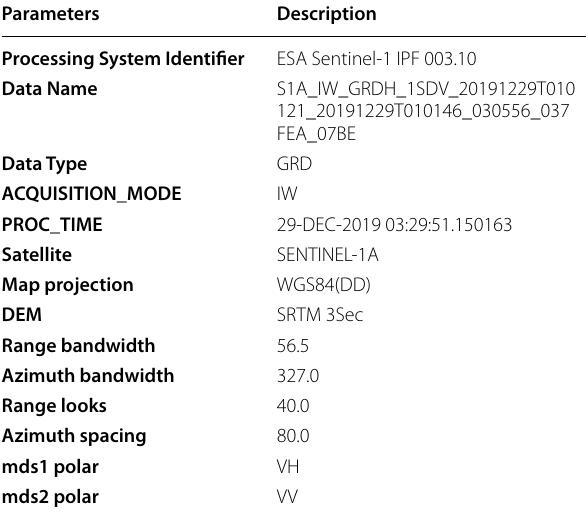
Table 2 Metadata of Sentinel 1A/B dataset